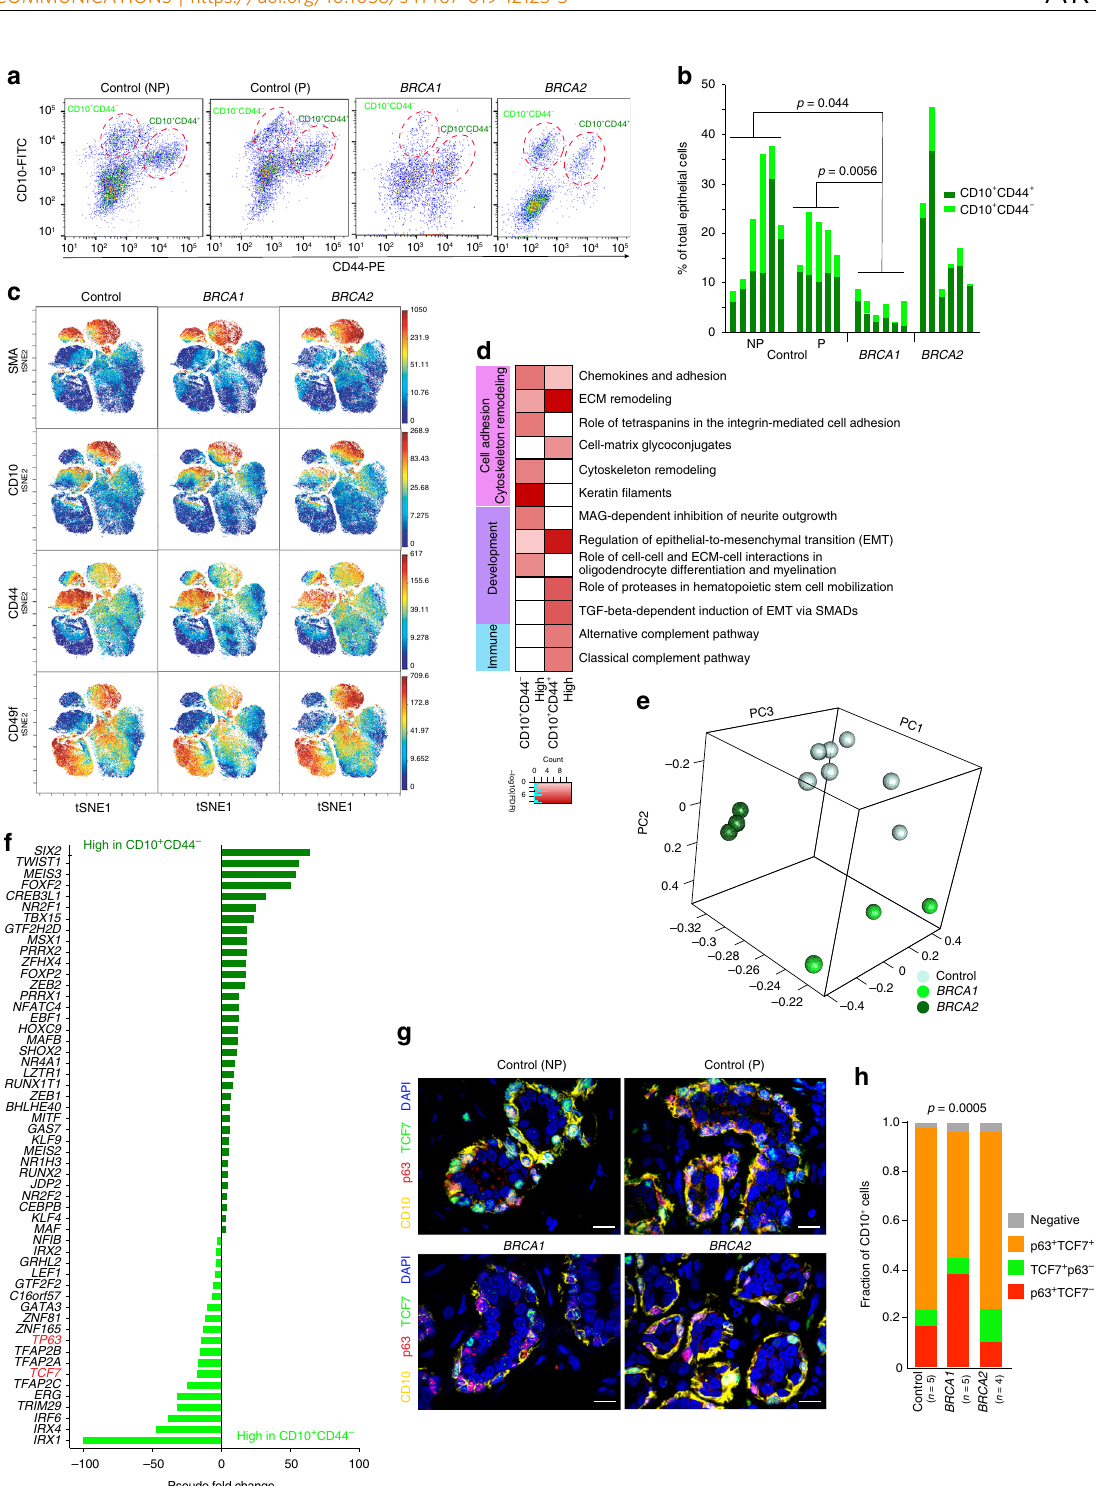
re fl ecting germline mutation status (Fig. 1e). Genes highly expressed in BRCA1 -mutant CD10 + cells were enriched in DNA replication-related functions, whereas BRCA2 -mutant CD10 + cells showed a decrease in keratins and an increase in immune-related genes (Supplementary Fig. 1g and Supplemen- tary Data 3). TFs play key roles in cellular differentiation. Thus, we identi fi ed TFs differentially expressed between CD10 + CD44 − and CD10 + CD44 + cells including many homeobox genes